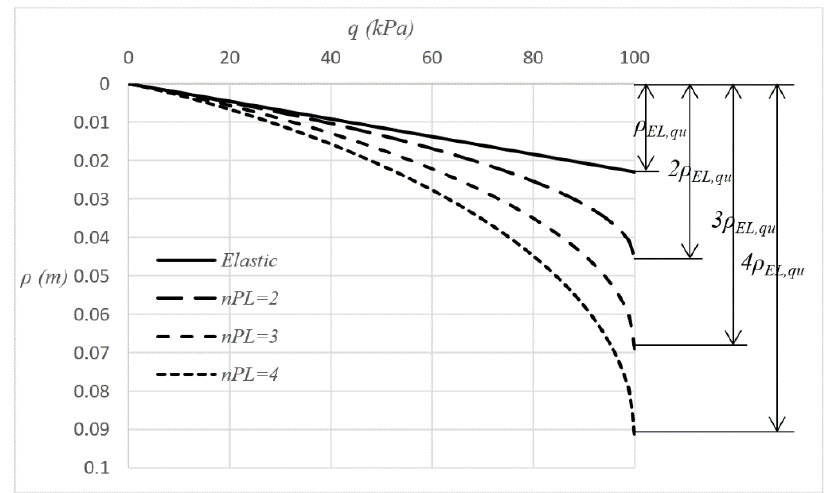
n can be any positive real number PL